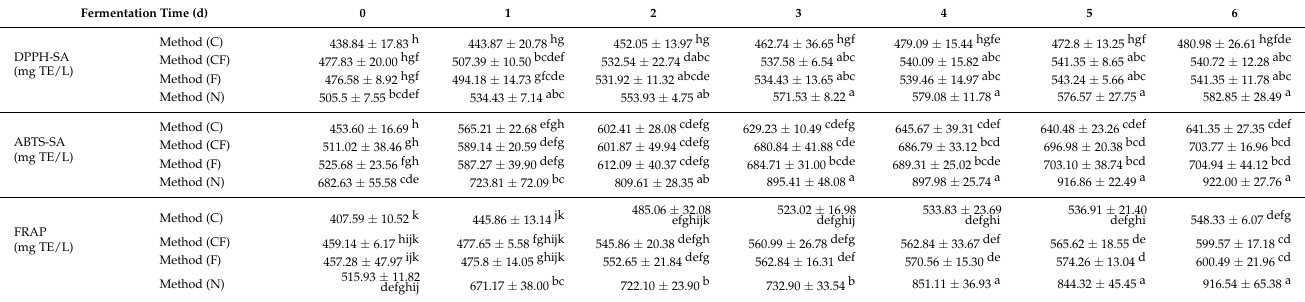
Table 2. Changes of DPPH-SA, ABTS-SA and FRAP in sea buckthorn juice determined by different